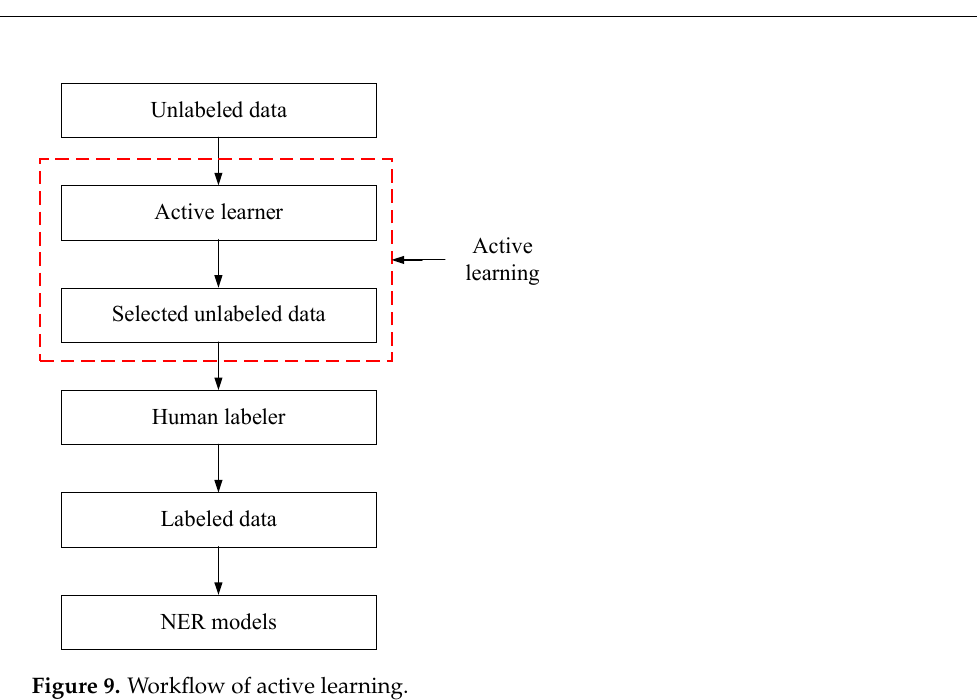
Figure 9. Workflow of active learning.